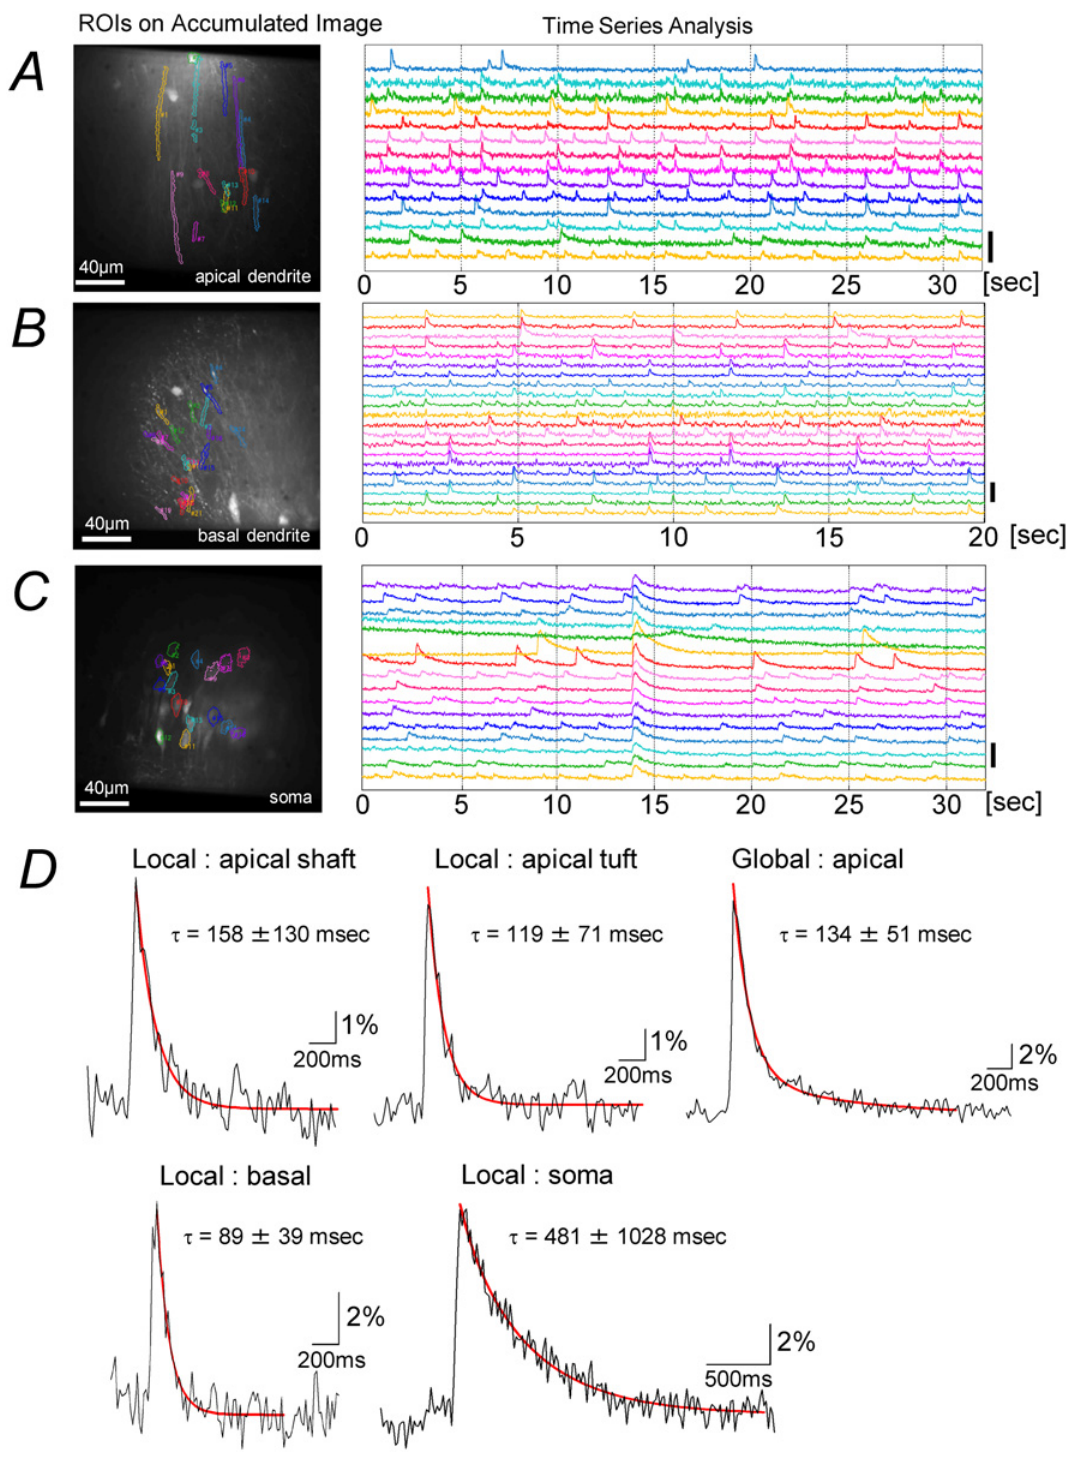
Fig 4. Spontaneous fast-Ca-transients recorded from different parts of a pyramidal neuron. ( A ) Distal part of the apical dendrites. The center of the image field was 300 μ m from the border between the cell layer and the str. pyramidale. The cASCF contained 7.5 mM K + ion. ( B ) Basal dendrites. The cACSF contained 6.5 mM K + ion. ( C ) Soma. The cACSF contained 3.0 mM K + ion. All the ROIs in panel ( A )-( C ) were determined using the NMF-based algorithm. Frame rate 16.4 msec. Time course of the fluorescent intensity recorded at the ROIs shown on the left panels with different colors are shown on the right panels using the same colors. Scale bar ( Δ F/F): 20%. ( D ) Comparison of the decay time constant ( τ ) of the fast-transients from different locations.